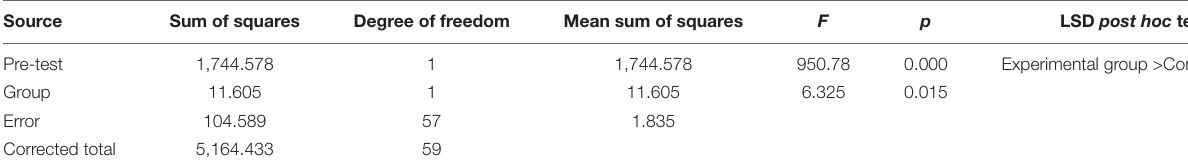
TABLE 5 | Summary of post hoc comparison for oral proficiency.